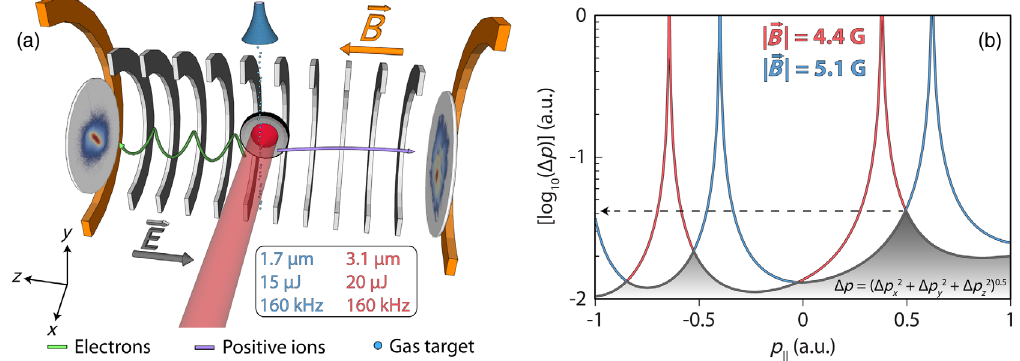
FIG. 7. (a) The experimental apparatus used to study SFP at long wavelengths. The operating principle of the ReMi is described in the text. The 160-kHz OPCPA has two outputs that can be focused into a supersonically expanding gas jet to induce SFI. The full 3D momentum distribution of the interaction can be measured. (b) The momentum resolution of the ReMi as a function of p jj for two low values of the magnetic field. The “ nodes ” can be eliminated by stitching the results of multiple measurements with different values of